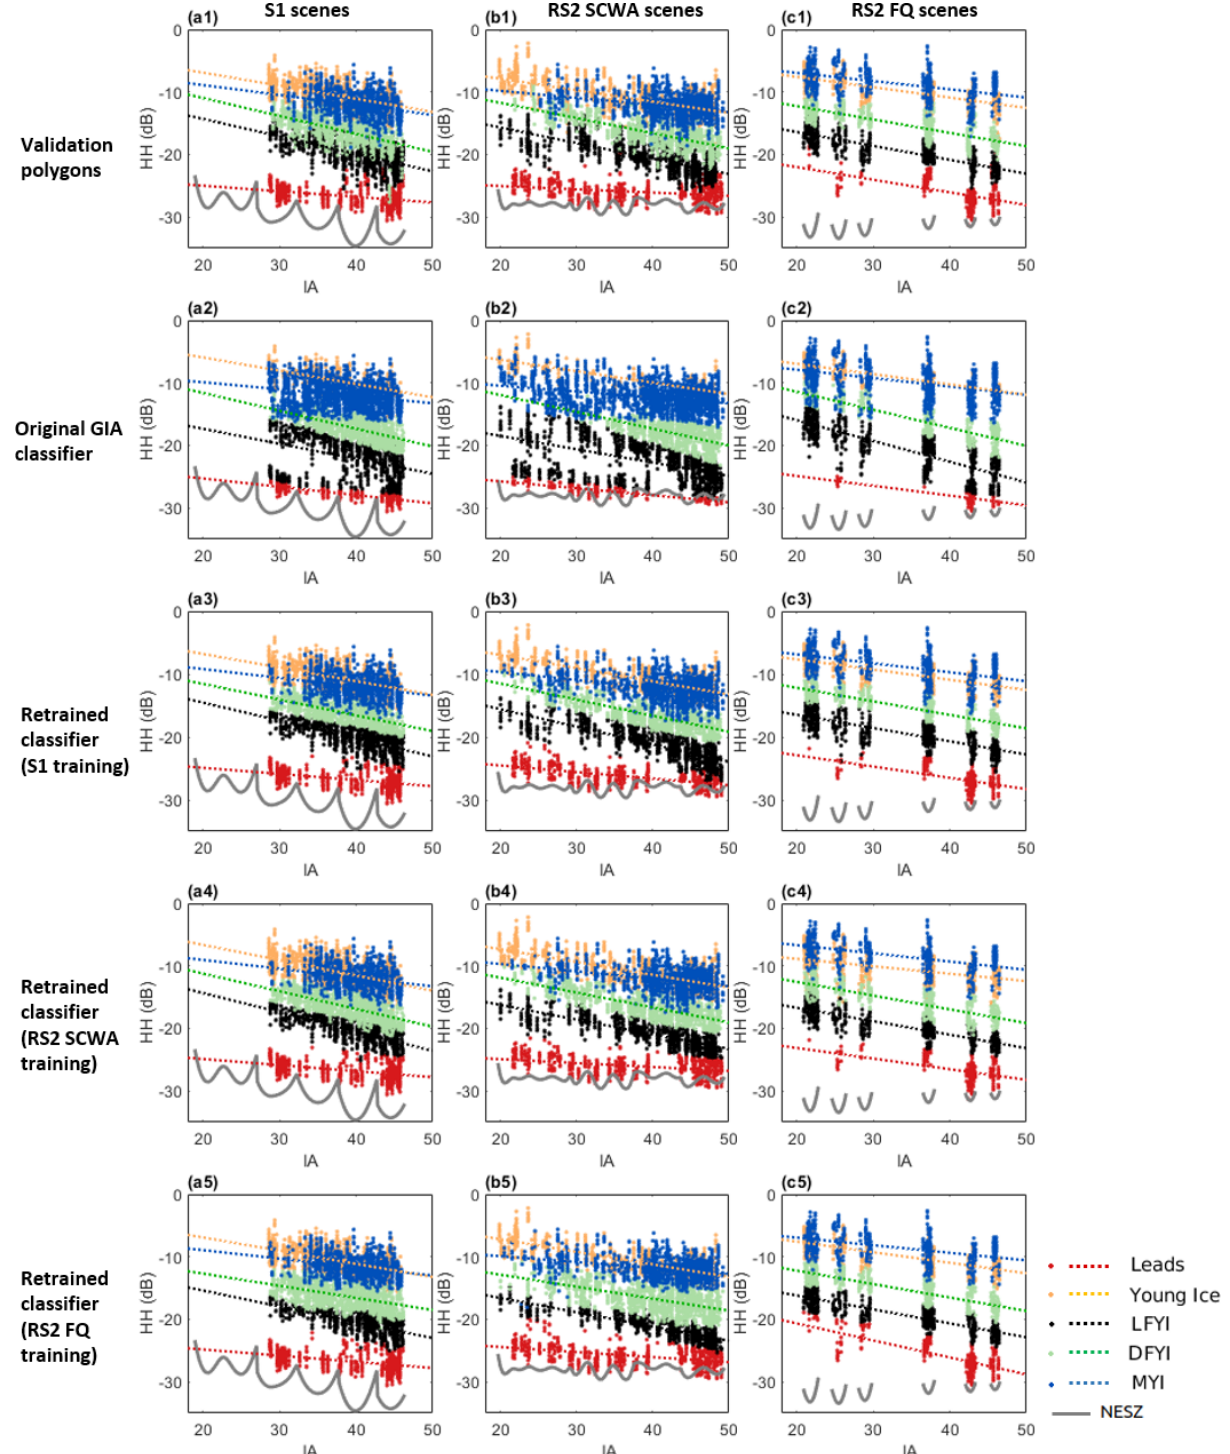
Figure 7. HH–IA scatter plots, least-squares regression lines for different ice types and NESZ values for different datasets.